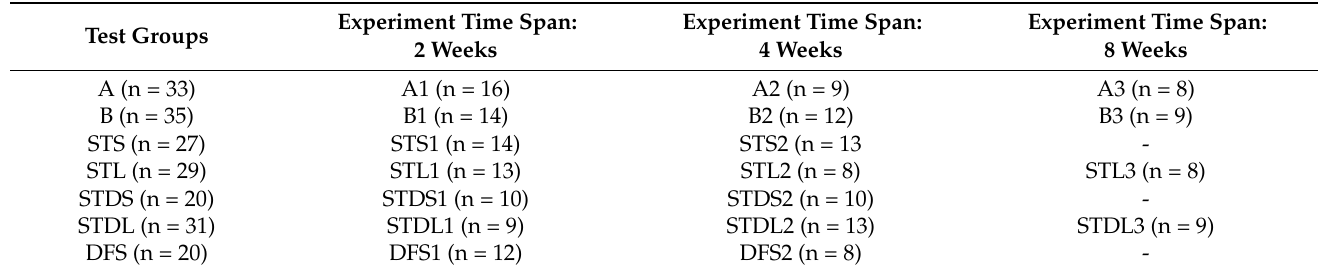
Table 1. Groups’ classification. Seven groups were created according to route of drug administration and type of drug. Eighteen subgroups created according to experiment time span. Sample size (n) is inhomogeneous among groups where animals died due to toxicity of the administered medication or due to the destruction of the samples during preparation for histological